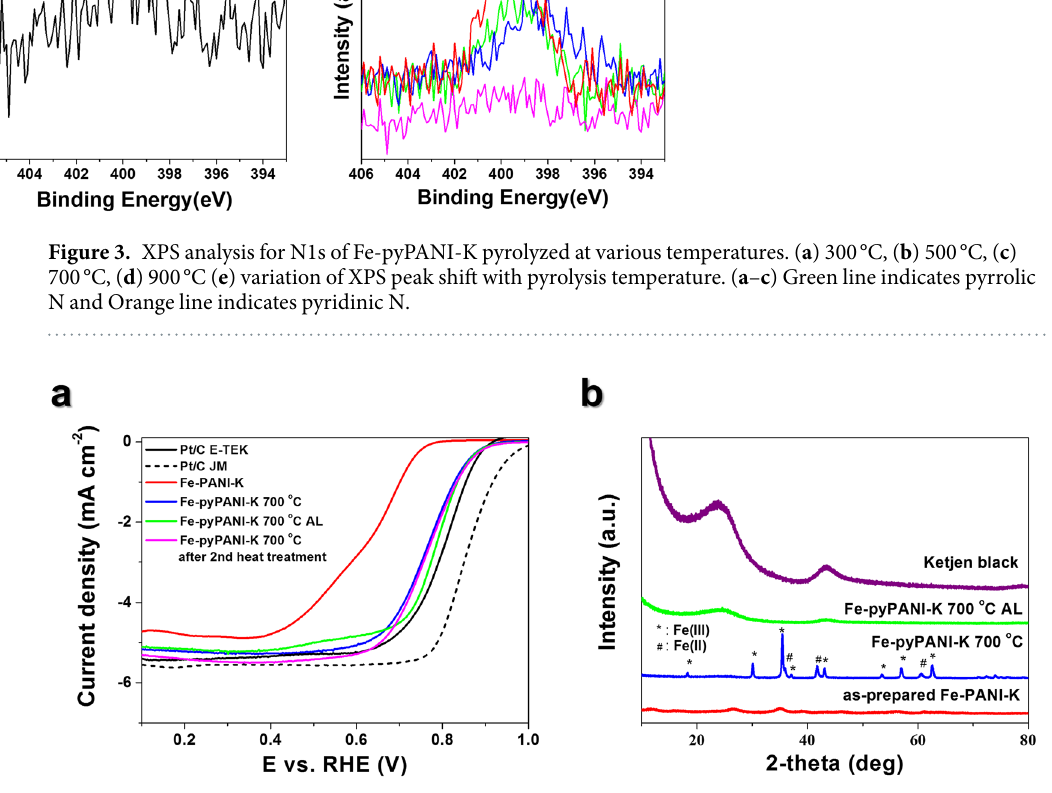
Figure 4. Electrochemical characterization and XRD analysis. ( a ) ORR performance graphs for the different types of catalyst on 0.24 mg cm − 2 catalyst loaded RDE at 1600 rpm in 25 °C O 2 saturated 0.1 M KOH electrolyte, ( b ) XRD patterns obtained for different catalyst